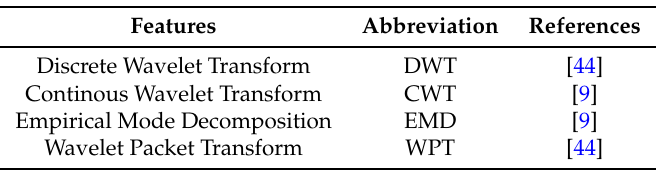
Table 3. Time Frequency domain